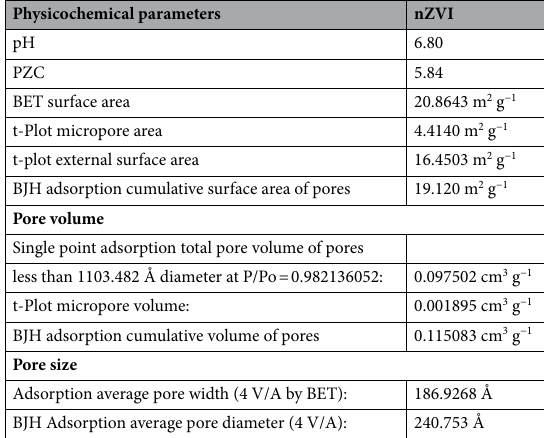
Table 1. Physicochemical parameters of nZVI.